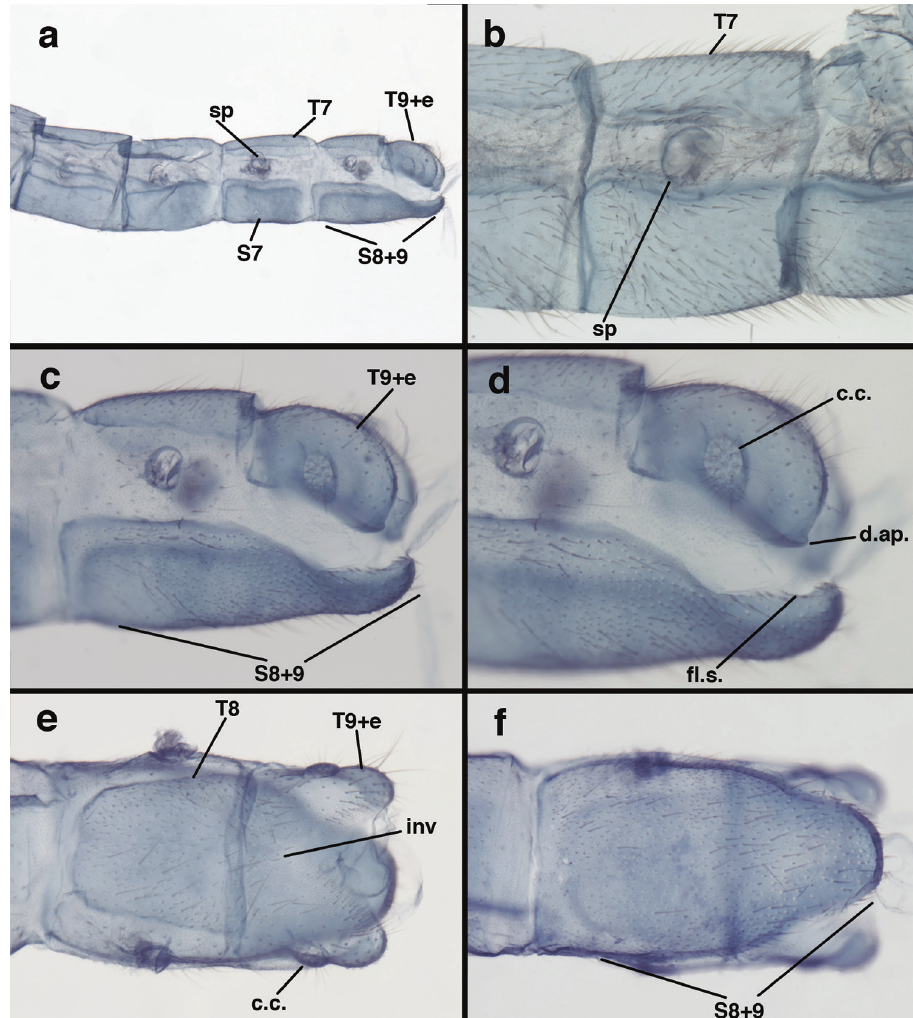
Figure 23. Ungla curimaguensis Sosa: Mature male abdomen, ( a ) segments A5-terminus, lateral ( b ) seg- ment A7, lateral ( c ) segments A8 and A9, lateral ( d ) terminus, lateral ( e ) eighth tergite and fused ninth tergite+ectoproct, dorsal ( f ) sternite 8+9, ventral. c.c. callus cerci d.ap. dorsal apodeme fl.s. flanged setae inv dorsal invagination of T9+ectoproct sp spiracle T7, T8 seventh, eighth tergites T9+e fused ninth tergite and ectoproct S7 seventh sternite S8+9 fused eighth and ninth sternites ( a, c, d, e, f Venezuela, Aragua, Rancho Grande, USNM; b same,